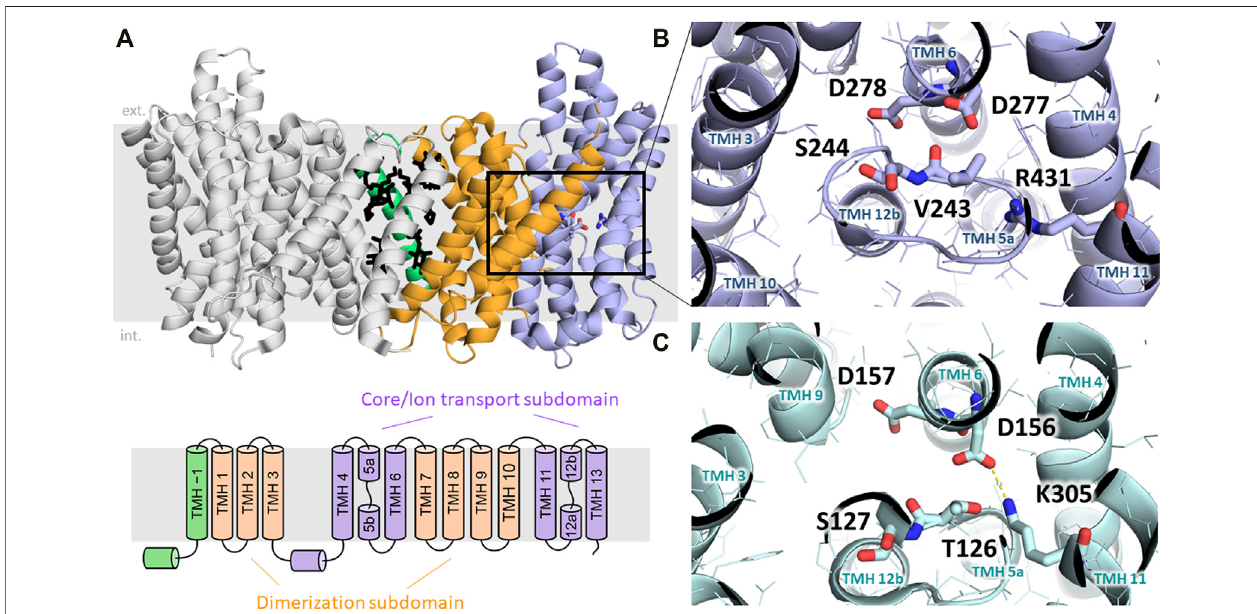
FIGURE 2 | Structural elements of NHA transporters. (A) Dimeric structure of bison NHA2 (SLC9B2) in nanodiscs is shown with the two protomers in different colors (PDB ID: 7P1K). The core/ion transport subdomain, the dimerization domain and the “ TM – 1 ” region are colored in blue, orange and green, respectively. Lipids modeled based on electron density information are shown in black (Matsuoka et al., 2022). Below, the transmembrane architecture of NHA2 is shown. (B) Ion-binding site of bison NHA2 is shown with residues relevant for ion exchange highlighted. D278 and D277 are reported to bind Na + , and D278 was shown to be involved in H + binding. S244 replaces the negative charge-compensation residue (see text). The backbone oxygen atom of V243 is predicted to interact with the bound Na + ion (Matsuoka et al., 2022). The lack of a salt bridge between D277 and R431 is related to electroneutral transport (Matsuoka et al., 2022). (C) Ion-binding side of the electrogenic NapA exchanger is shown (PDB ID:4BWZ), residues analogous to those on panel B are marked (Lee et al., 2013). Electrogenicity is conferred by the H + - binding residue K305, which is locked in a salt bridge with D156 upon H + binding (Lee et al.,